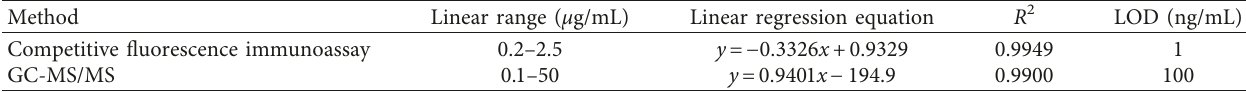
Table 1: Linear regression equations, correlation coefficients, and limits of detection of MOR.